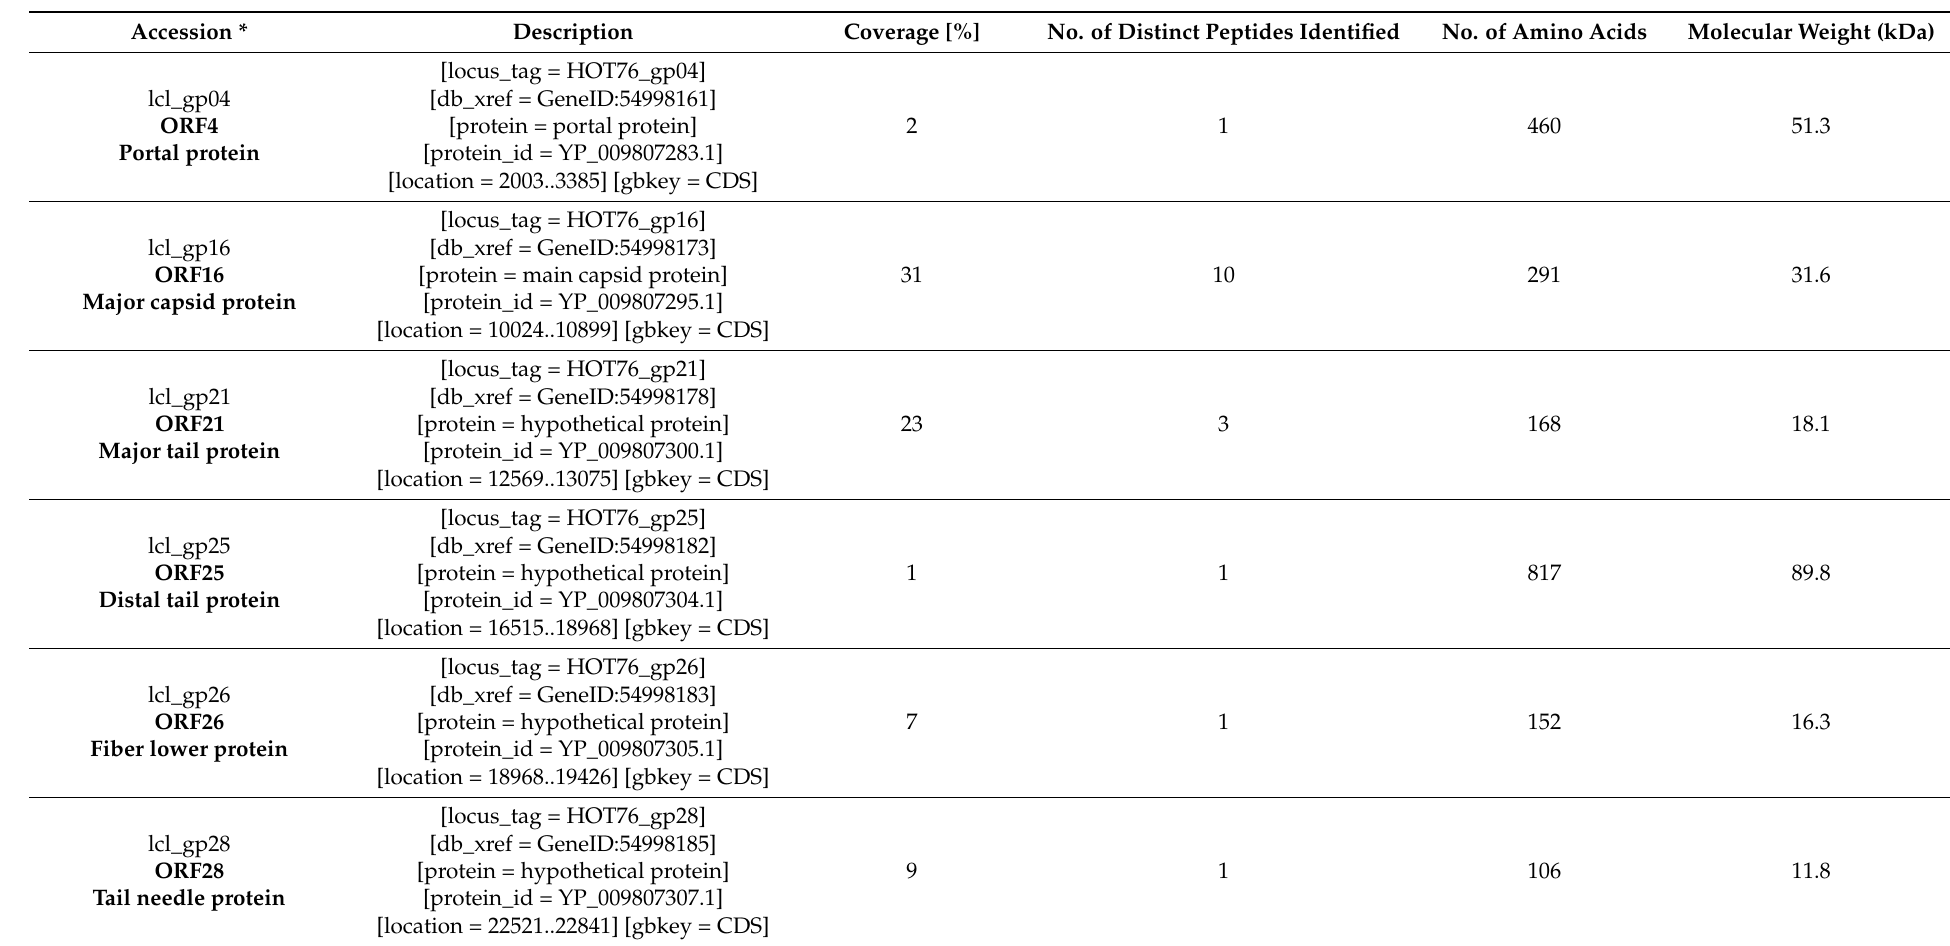
Table 1. Identified ORFs as structural proteins by